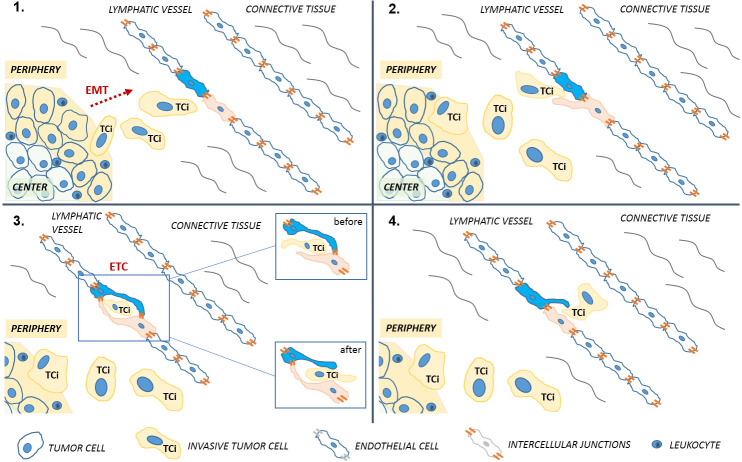
Schematic stepwise representation (A, B, C, D) of the main phases characterizing the endocanalicular transendothelial crossing (ETC). A: Invasive tumor cells (TCi) at the tumor periphery undergoing the epithelial-to-mesenchymal transition (EMT) process moving towards the lymphatic vessel. B: Early interaction between a TCi and one of the two endothelial cells initiating the ETC phenomenon. The endothelial cell undergoes morphostructural changes typical of such process, namely “finger-like projections”. C: Interplay between a TCi and the two endothelial cells during ETC in which the TCi starts entering the early opening due to modifications of the first endothelial cell, which creates a transient inner channel. The TCi begins to exit the channel due to the modifications of the second endothelial cell involved. D: A TCi reaching the lymphatic vessel lumen, after complete crossing of the lymphatic endothelial wall without involving endothelial cell intercellular junctions. PERIPHERY: peripheral area of the tumor; CENTER: central area of the tumor.